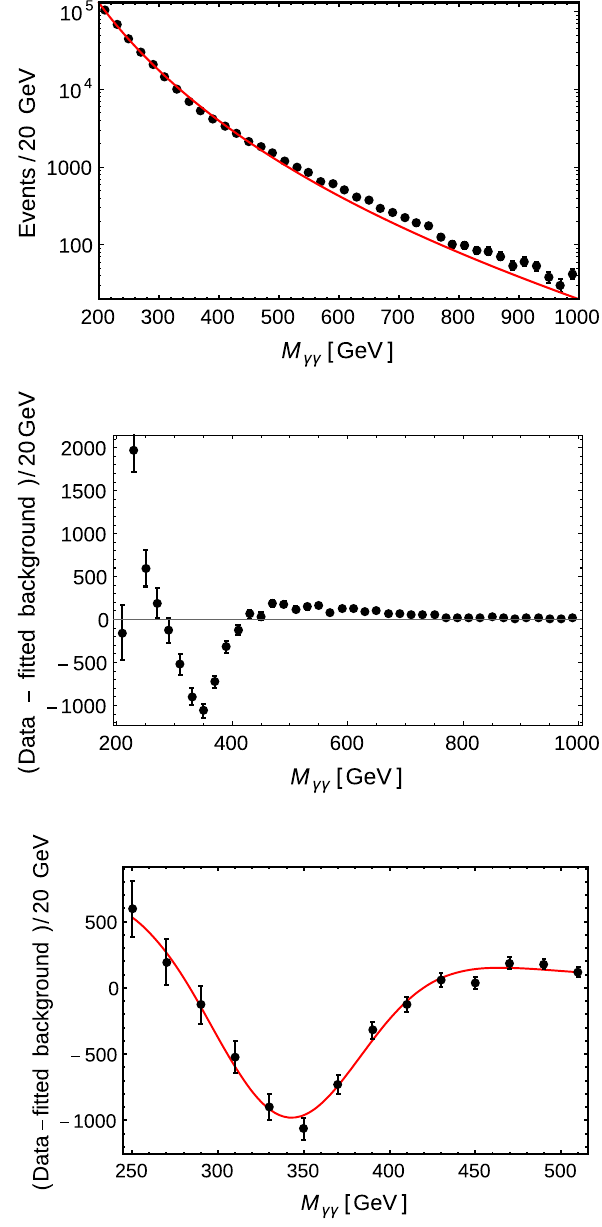
Fig. 3 The invariant mass distribution of the two photons from the gluon fusion process. These events are obtained after applying the cuts defined in Eq. (4). The solid line in the top plot shows a smooth fit of the binned events in the 200 GeV ≤ M γγ ≤ 1000 GeV range with the smooth ATLAS fitting function [Eq. (5)]. The middle plot shows the difference between the simulated events and the smooth fit. A clear dip is seen at M γγ ≈ 2 m t . In the range 250 ≤ M γγ ≤ 510 GeV the difference is fitted with the function shown in Eq. (6) that captures the dip better as shown in the bottom